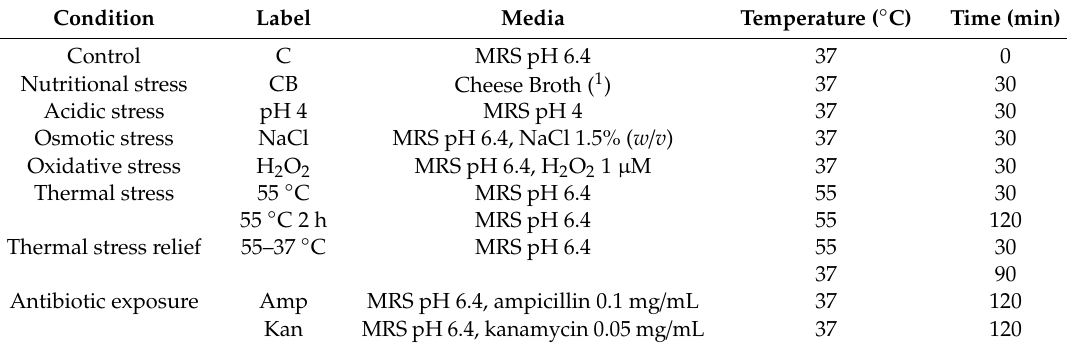
Table 3. Culture conditions for DinJ-YafQ expression